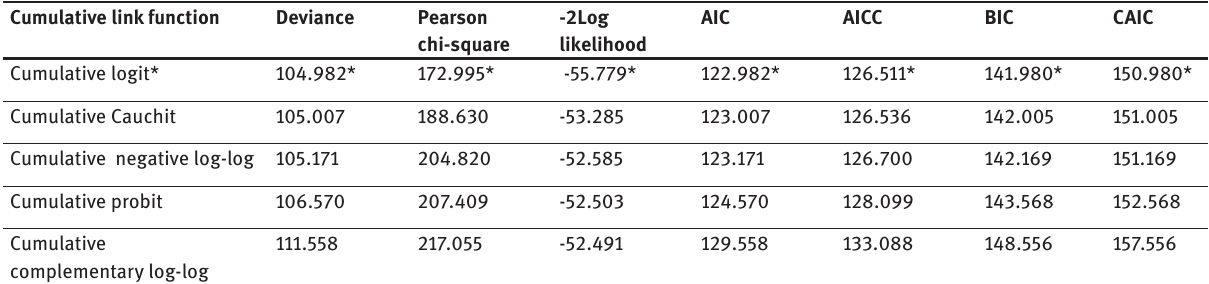
Table 5: Results for goodness-of-fit test statistics comparing different cumulative link functions in the GLM for the world energy security